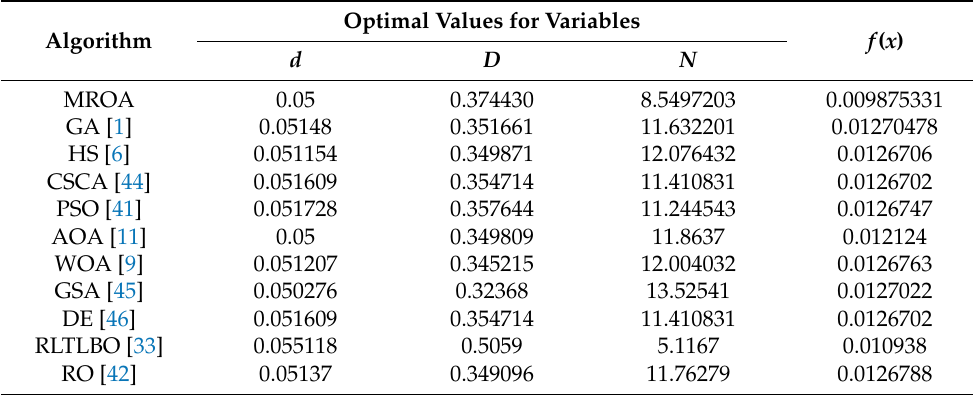
Table 12. Comparison of optimal solutions for the tension/pressure springs design problem.